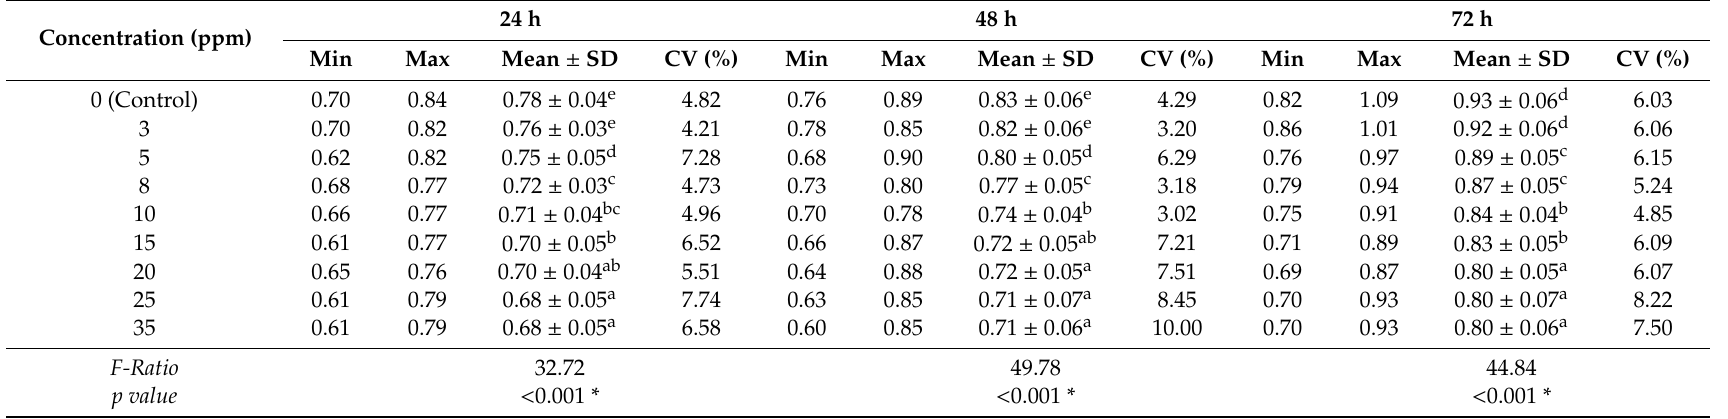
Table 1. Main summary statistics of body length measurements (mm) of Artemia nauplii exposed to di ff erent concentrations of BPA for 24, 48, and 72 h. * Significant di ff erences. Means with di ff erent superscript letter(s) are significantly di ff erent. Concentration (ppm)